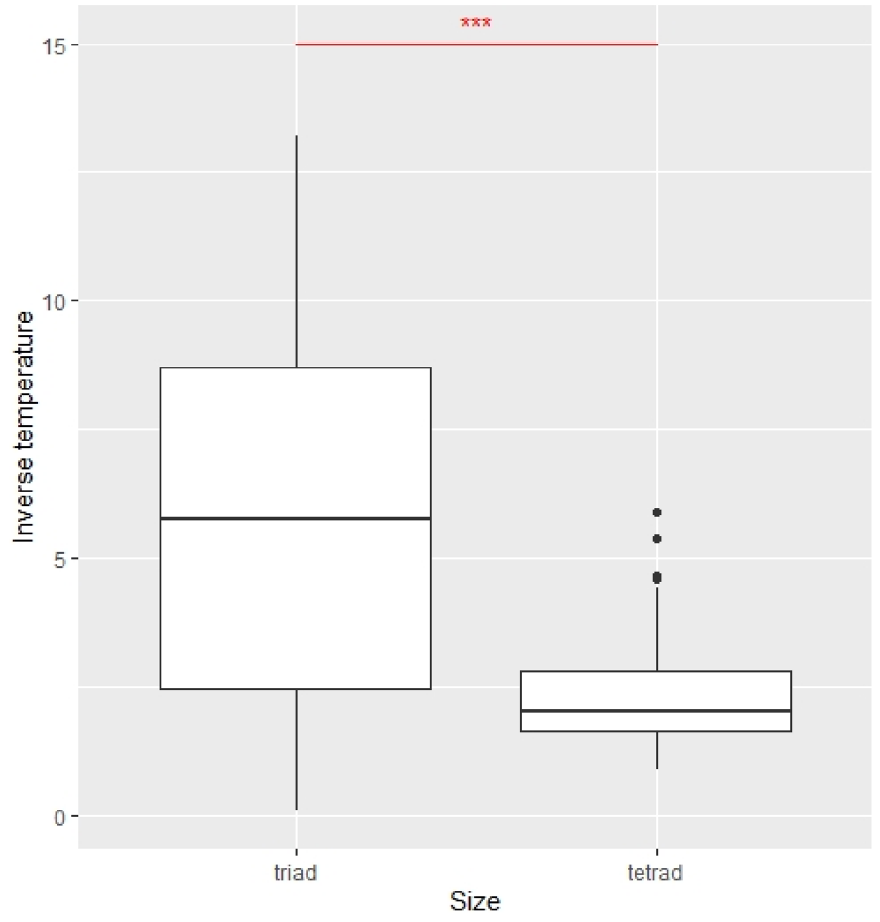
Figure 2. Comparison of average inverse temperatures ( β ) of triads and tetrads. The Kruskal–Wallis test was applied. ***p <